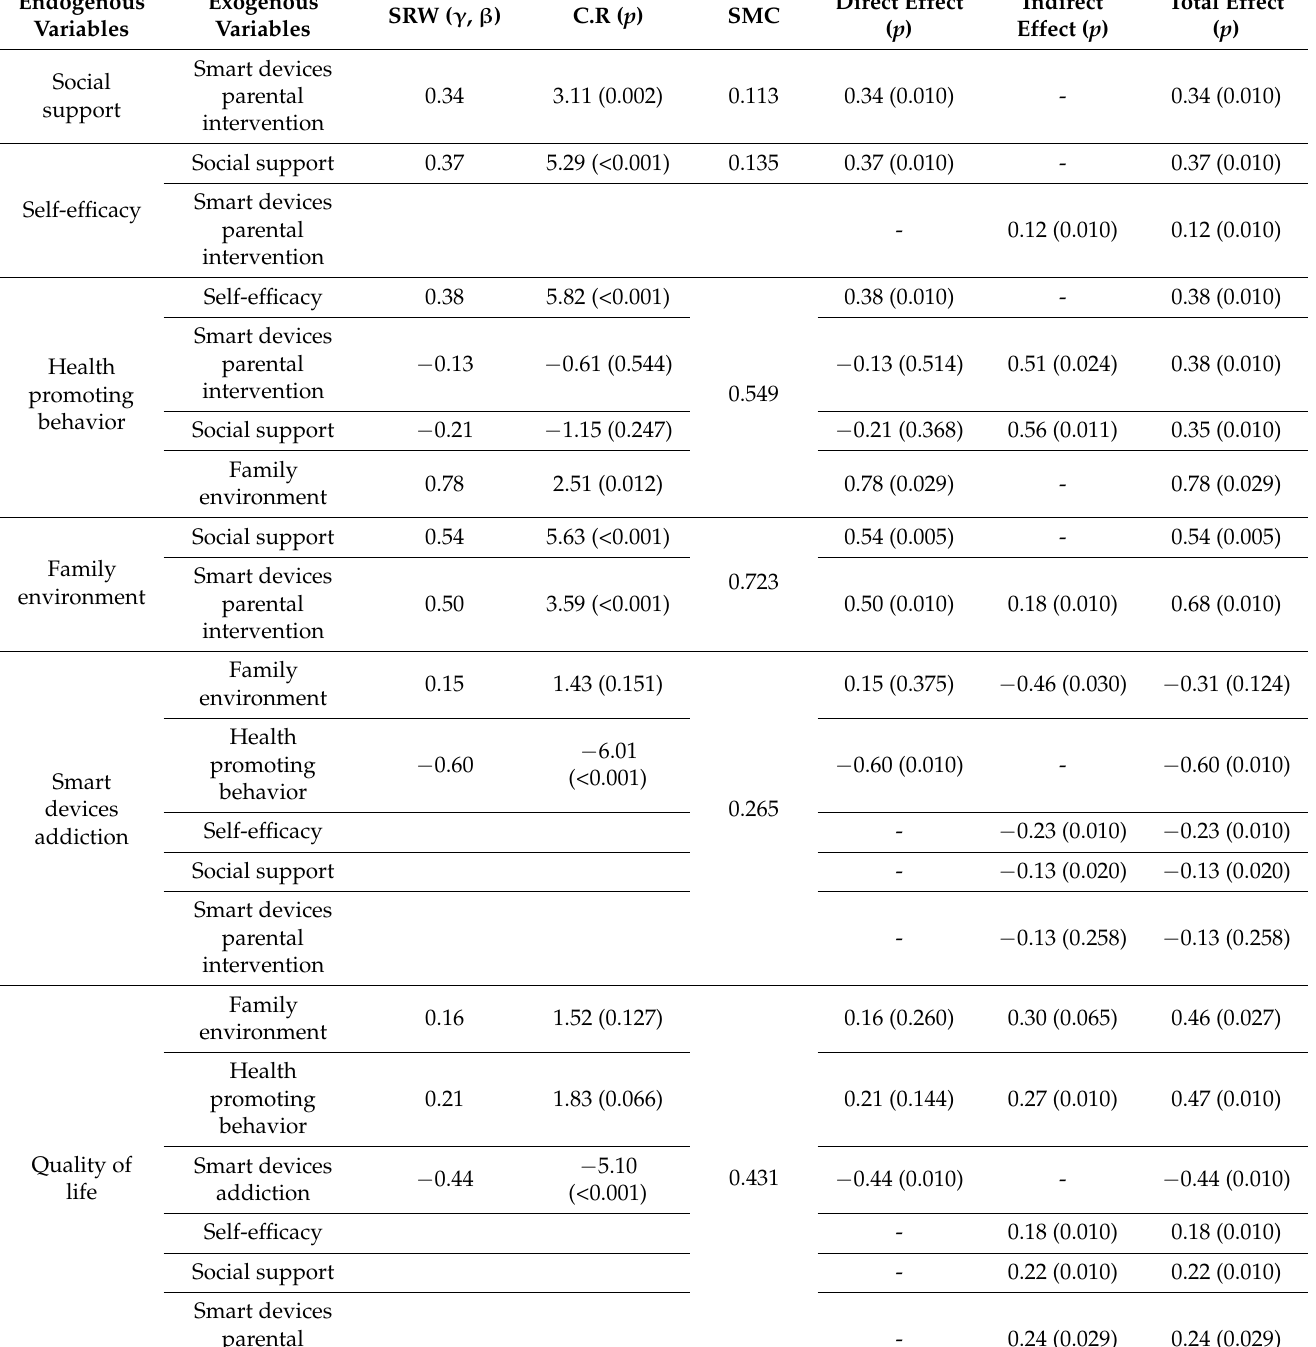
Table 3. Standardized estimates, standardized direct, indirect, and total effects for the hypothetical model (N = 223).